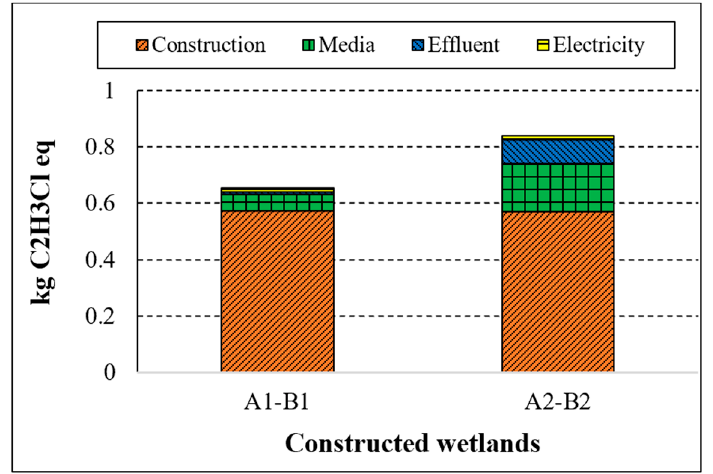
Figure 8. Impact assessment from non-carcinogens for two different CW systems.